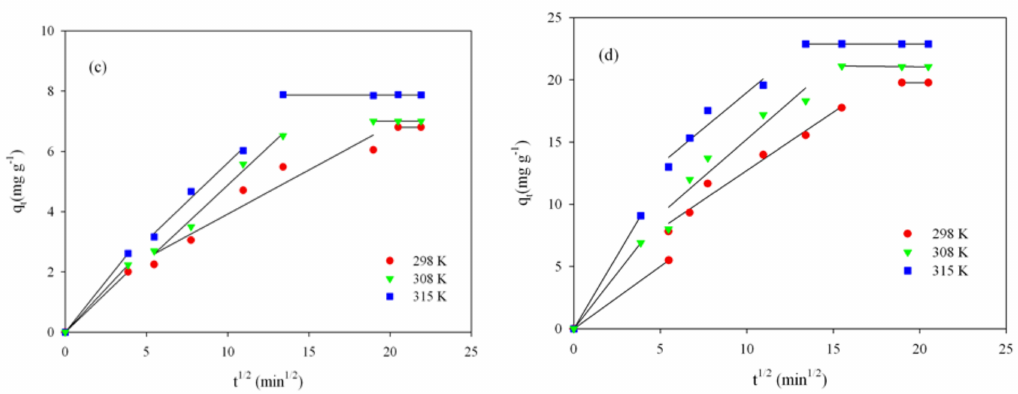
Figure 7. Intraparticle diffusion model for RB adsorption onto ST-A ( a ) and CWZ-22 ( c ), and for AY17 adsorption onto ST-A ( b ) and CWZ-22 ( d ).